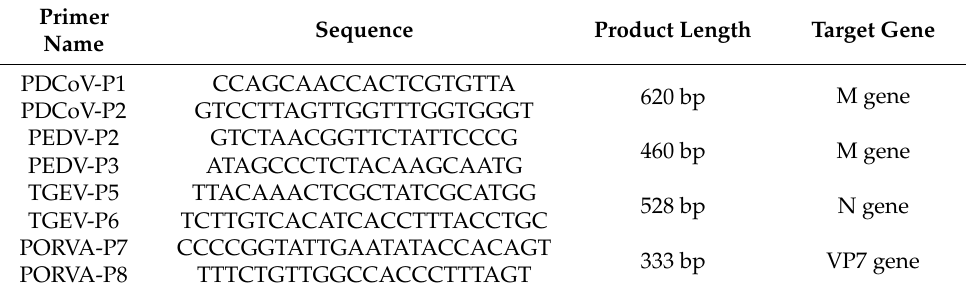
Table 2. Primers for swine enteric virus gene detection.